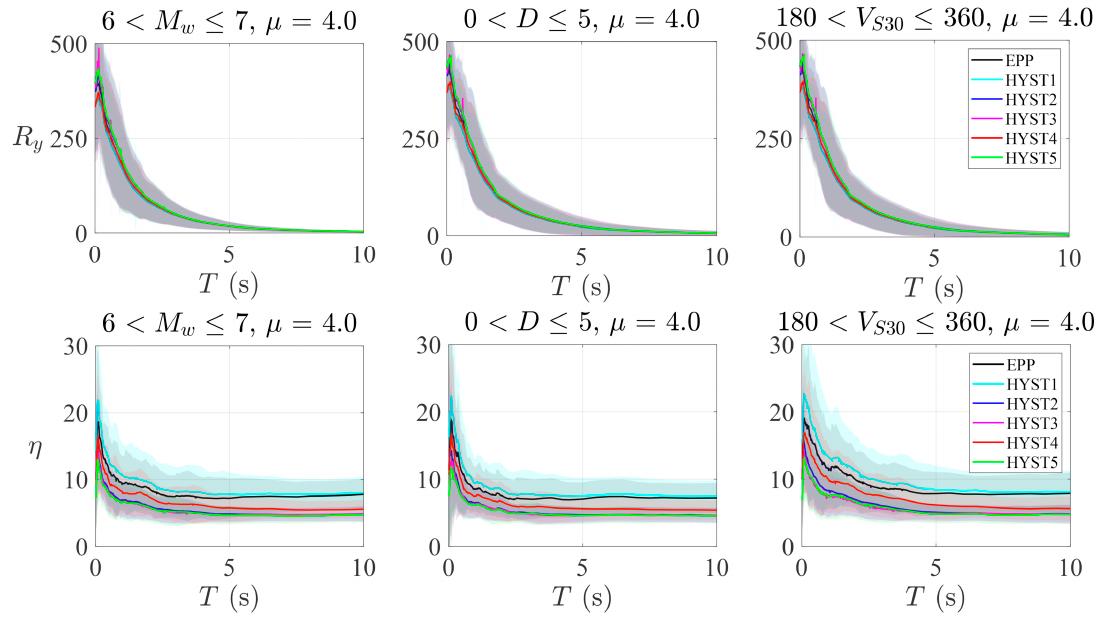
Figure 9. Influence of the hysteretic model on the spectra of elastic limit strength R y and cumulative plastic deformation ratio η for a ductility level µ equal to 4 (filled area: envelope of the spectra; solid line: mean spectrum).